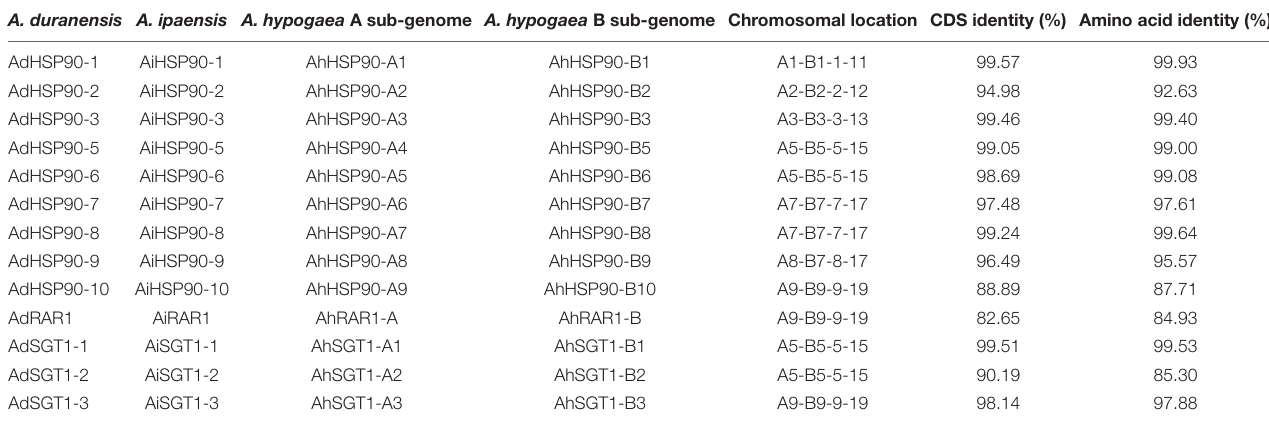
FIGURE 2 | Chromosomal locations of HRS-related genes in the A. hypogaea genome. The chromosome numbers are shown at the top of each chromosome (black bars). The left side of each chromosome corresponds to the approximate location of each HRS-related gene. TABLE 2 | Orthologous gene pairs in Arachis